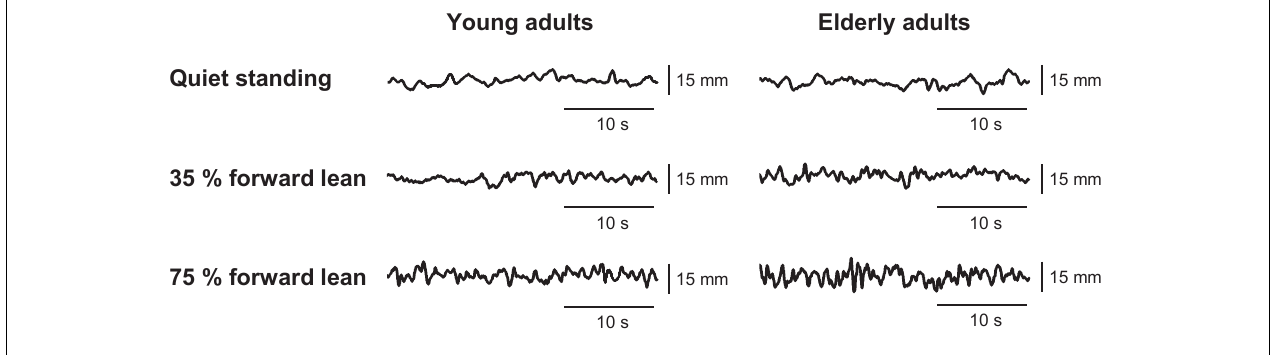
FIGURE 2 | Example data of anteroposterior center of pressure (COP) displacement from an individual young adult and an individual elderly adult.